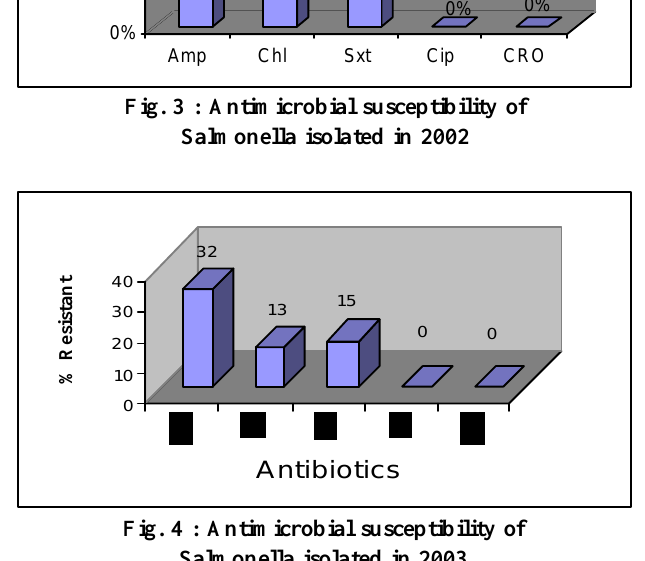
Fig. 4 : Antimicrobial susceptibility of Salmonella isolated in 2003